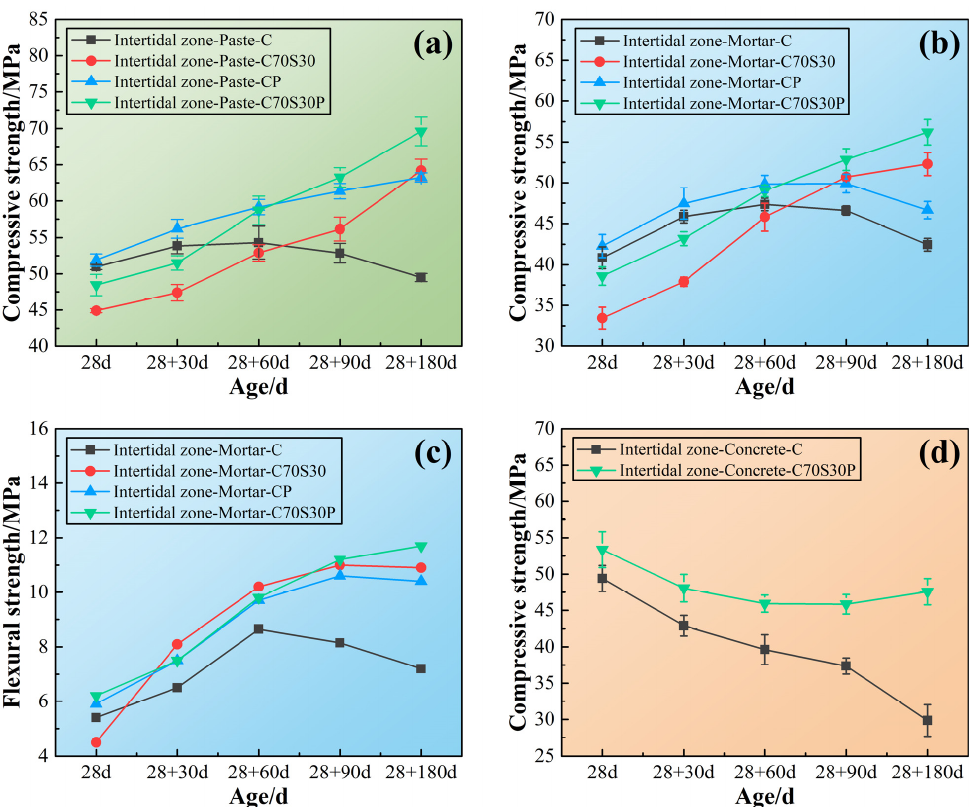
Figure 7. The mechanical properties of CBRM serving in the intertidal zone simulated environment. ( a ) CBRM-Paste, ( b , c ) CBRM-Mortar, and ( d ) CBRM-Concrete. Second, the influence of slag powder and polypropylene fibers on the durability of